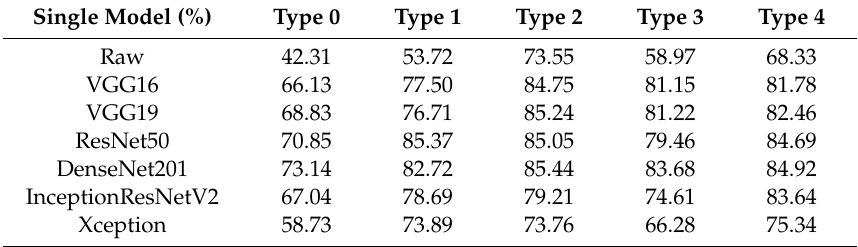
Table 10. Classification performance of the CNNs with data augmentation under transfer learning (4 classes).